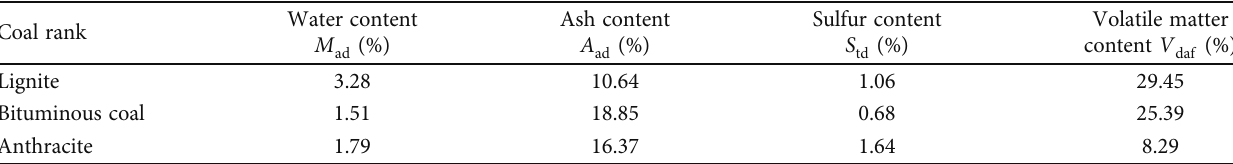
Table 1: Proximate analysis of coal